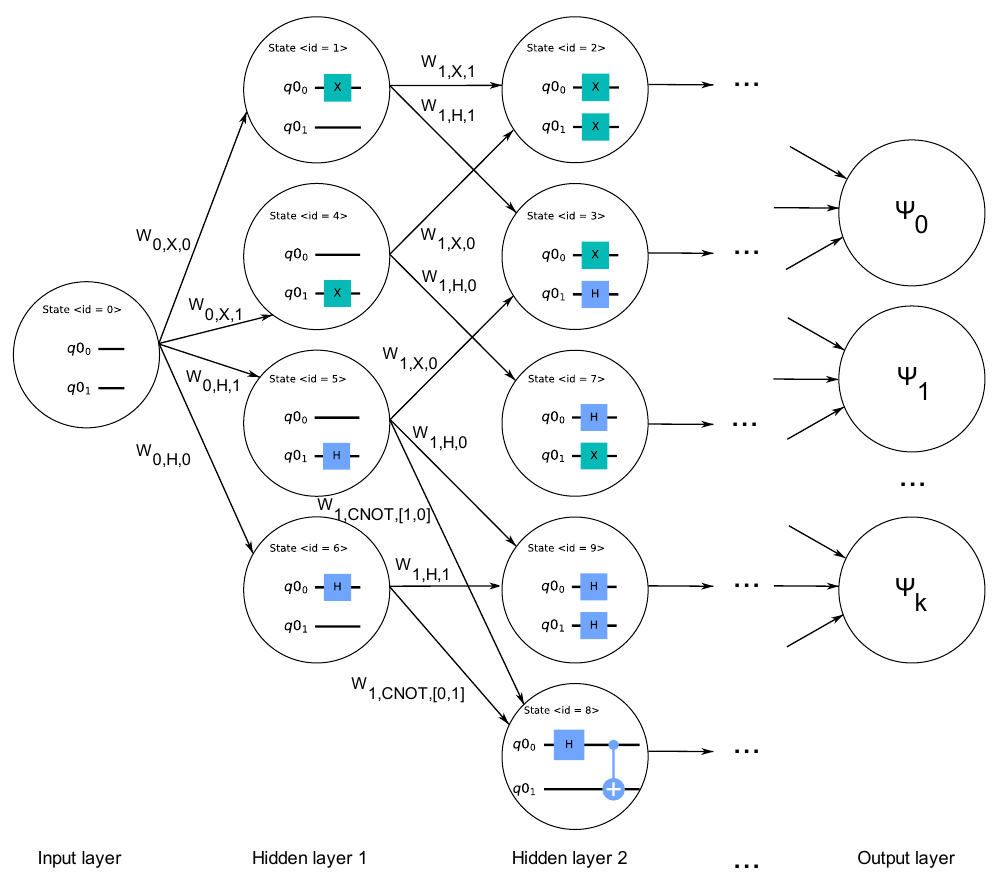
Figure 4. Design of a neural network using the quantum states from the graph. The configuration of the output layer depends on the states from the inner layers; the data from the graph, analyzed at different exploration depths, were used to populate the final nodes in each neural network architecture.